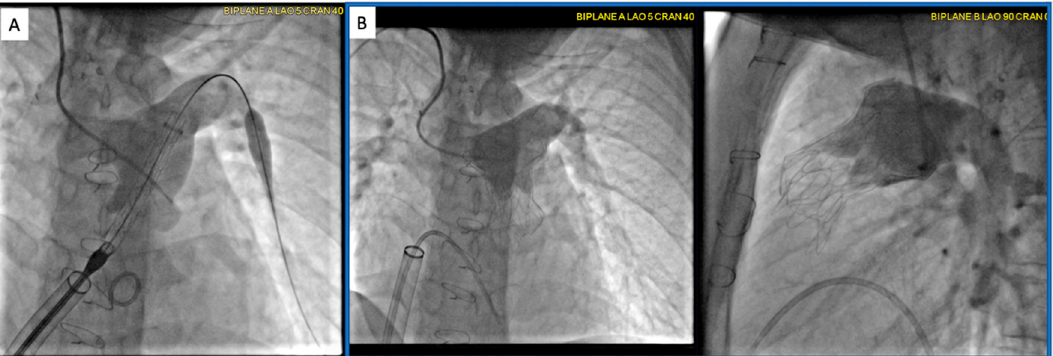
Figure 13. Intra-procedural angiograms demonstrating the 25 mm Harmony valve positioning ( A ) and final placement ( B ) on AP and Lateral projections in a patient with pulsatile Glenn physiology. A 26-French DrySeal sheath was advanced from the femoral venous access to deliver the Harmony valve. Additional access was obtained from the right internal jugular vein for angiography during valve placement.